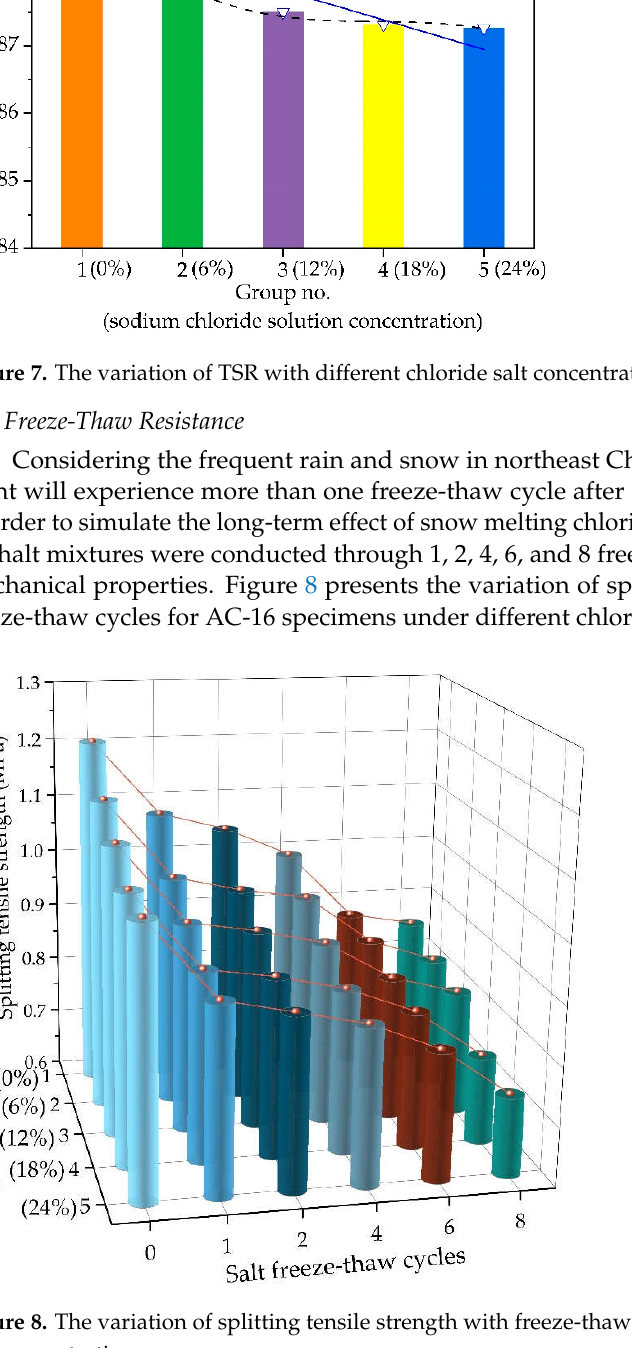
12 of 16 Figure 6. The variation of low-temperature IDT strength with different chloride salt concentrations. 4.3. Water Stability The freeze-thaw splitting tensile strength ratio (TSR) of AC-16 under different chlo- ride salt concentrations is plotted in Figure 7. The water stability of asphalt mixture spec- imens soaked in water (0%) and chloride salt solution (6%, 12%, 18%, and 24%) is reduced with the increase in sodium chloride solution concentration. The TSR results of the asphalt mixture specimens soaked in chloride salt solution of 6%, 12%, 18%, and 24%, are reduced by 1.4%, 1.8%, 2.0%, and 2.2%, respectively, compared to the asphalt mixture soaked in water (0%). When the chloride solution concentration is greater than 6%, the slope of the